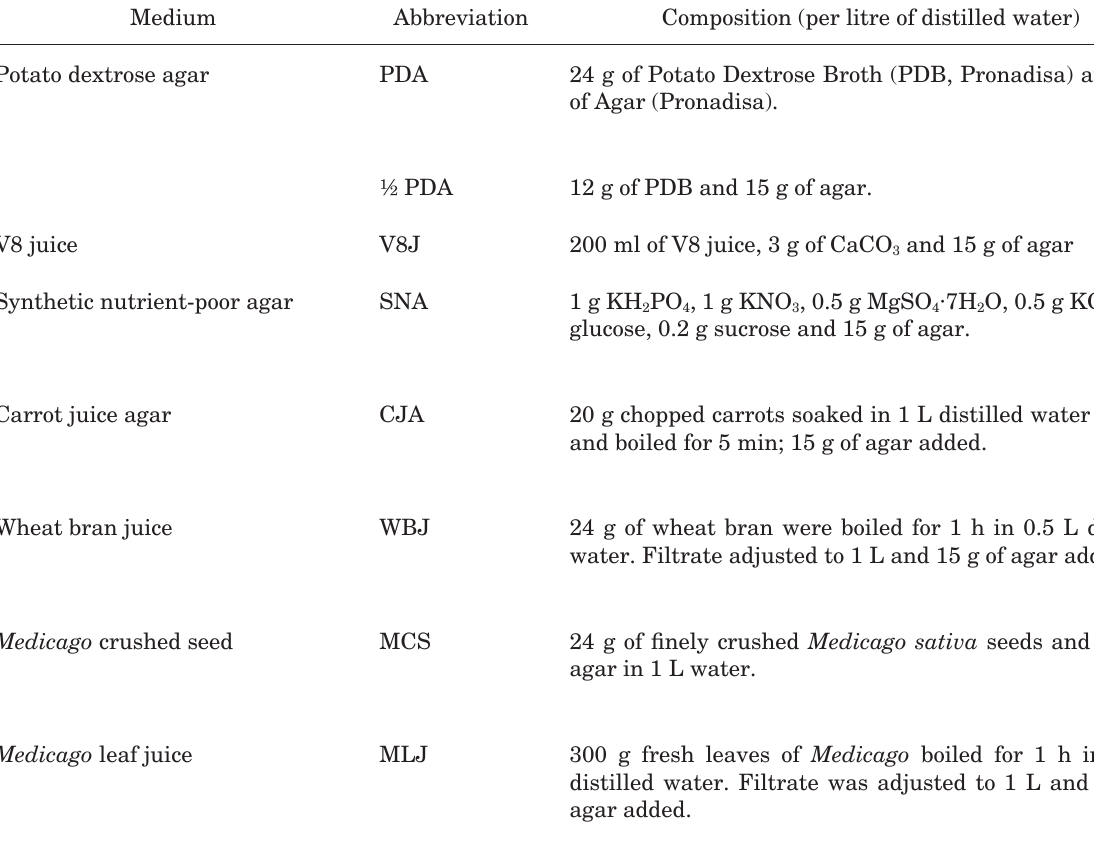
Table 1. The composition of the culture media